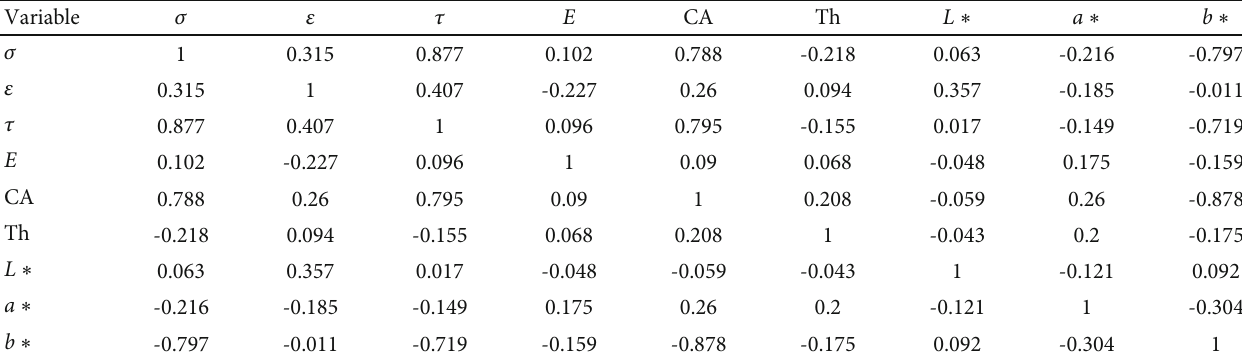
Table 9: Coe ffi cient matrix of aged PVDF-coated fabrics (group